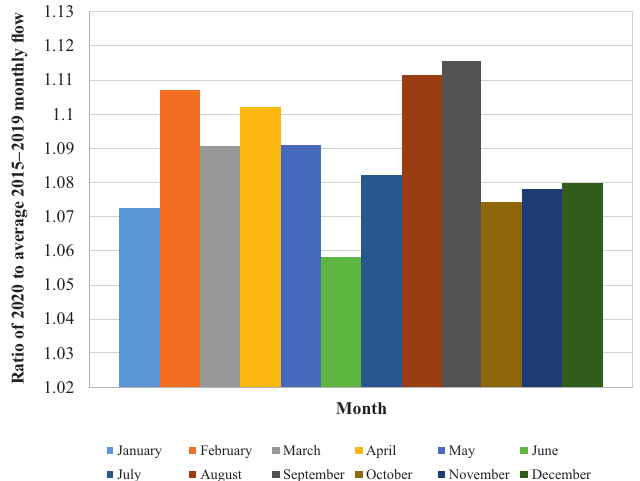
Figure 4. Ratio of year 2020 to average 2015–2019 monthly flow